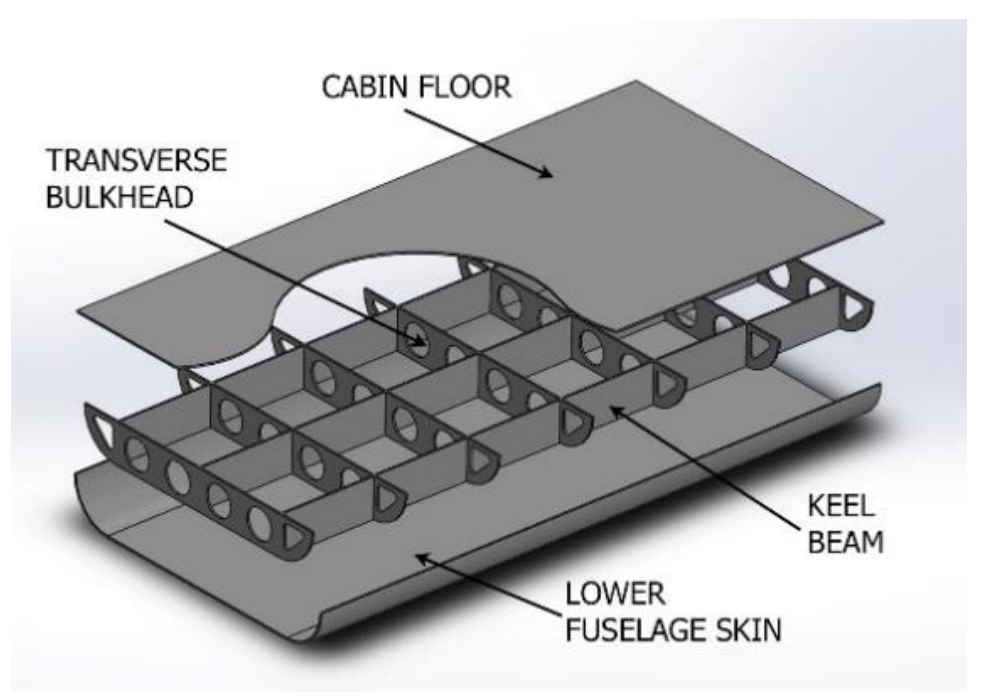
Figure 2. Typical subfloor layout, with upper and lower skin, keel beams and transversal bulkheads.